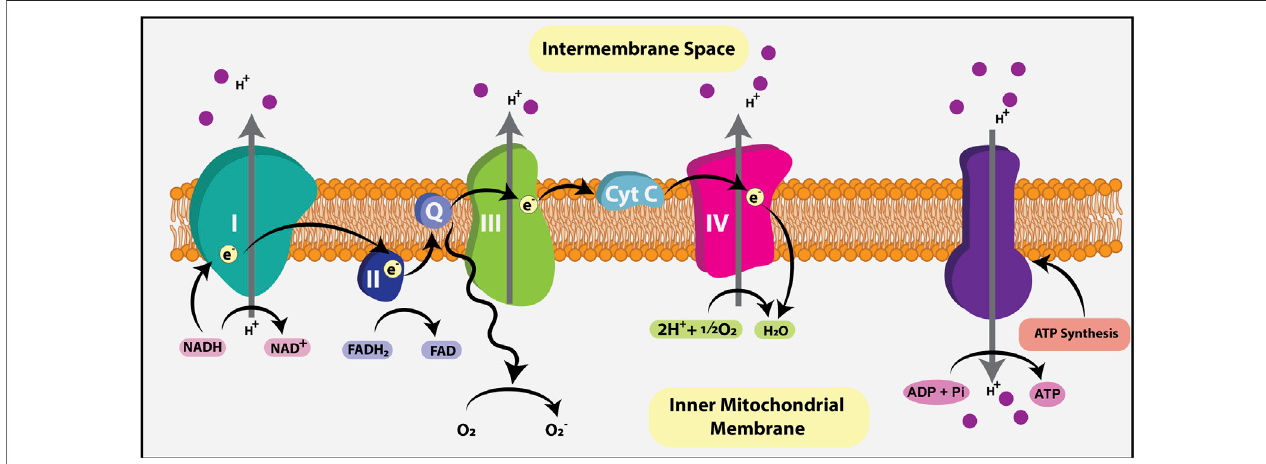
FIGURE 3 | Electron transport chain (ETC). The ETC generates ATP using the reducing agents NADH and FADH2, metabolic byproducts of the TCA cycle that donate electrons to the ETC. Electrons are shuttled through four transmembrane complex proteins (I-IV) in the IMM. NADH binds to complex I while FADH2 binds to complexII,initiatingelectron fl ow.TheETCuseselectrontransfertopumpaprotonintotheintermembranespace.Thisvoltagegradientgeneratesaprotonmotiveforce that drives O 2 -coupled ATP generation via ATP synthase, termed oxidative phosphorylation (OXPHOS). OXPHOS generates ~30 – 38 ATP molecules per molecule of